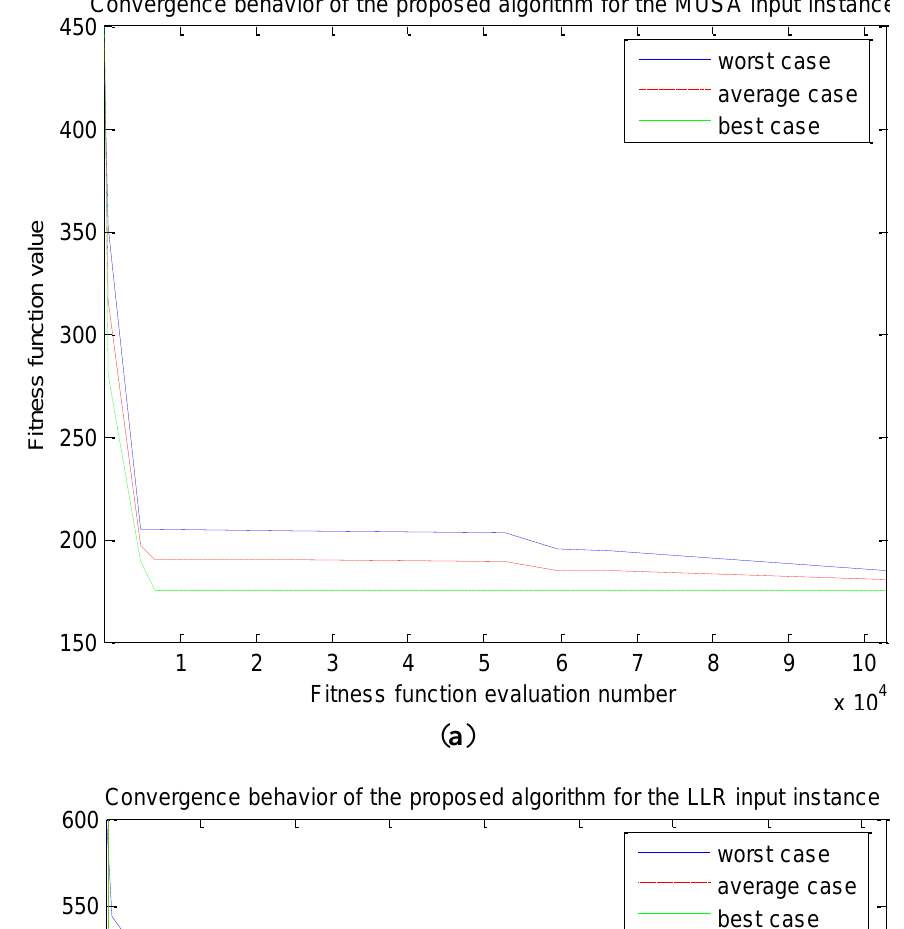
Figure 8. Convergence behavior of the proposed algorithm for four input